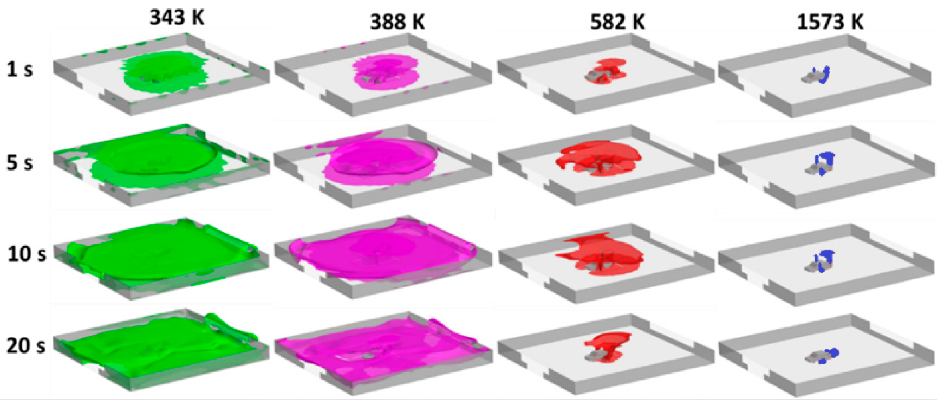
Figure 10. Iso-surfaces showing no-harm (343 K), pain (388 K) and fatality (582 K) limit temperatures for ignited hydrogen release in case 4 (TPRD = 2 mm, 0° angle downward release with tank blowdown and car body).